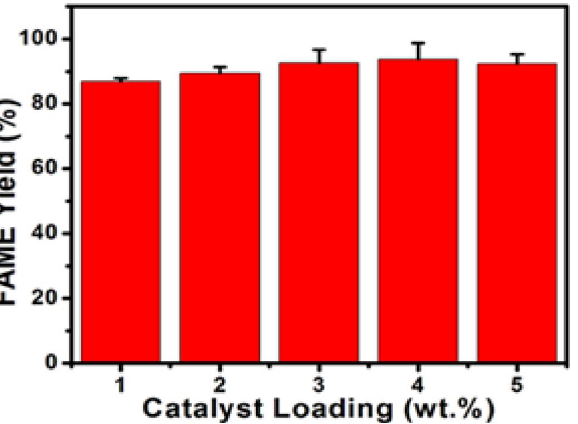
Figure 7. Influence of catalyst dosage on esterification process at 65 °C reaction temperature, 5 h reaction time, and 8:1 molar ratio of methanol to OA.